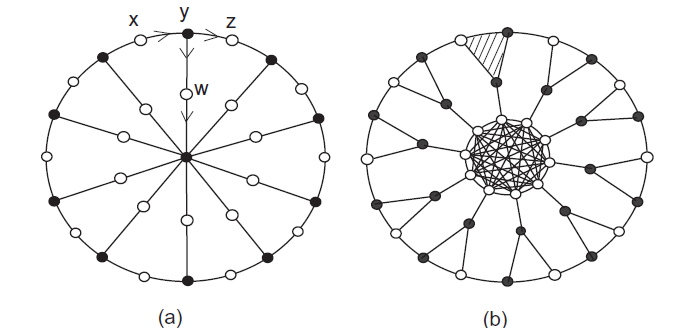
Figure 2. ( a ) Subdivision graph of wheel graph W n + 1 ; ( b ) Line graph of the subdivision graph of the wheel graph W n + 1